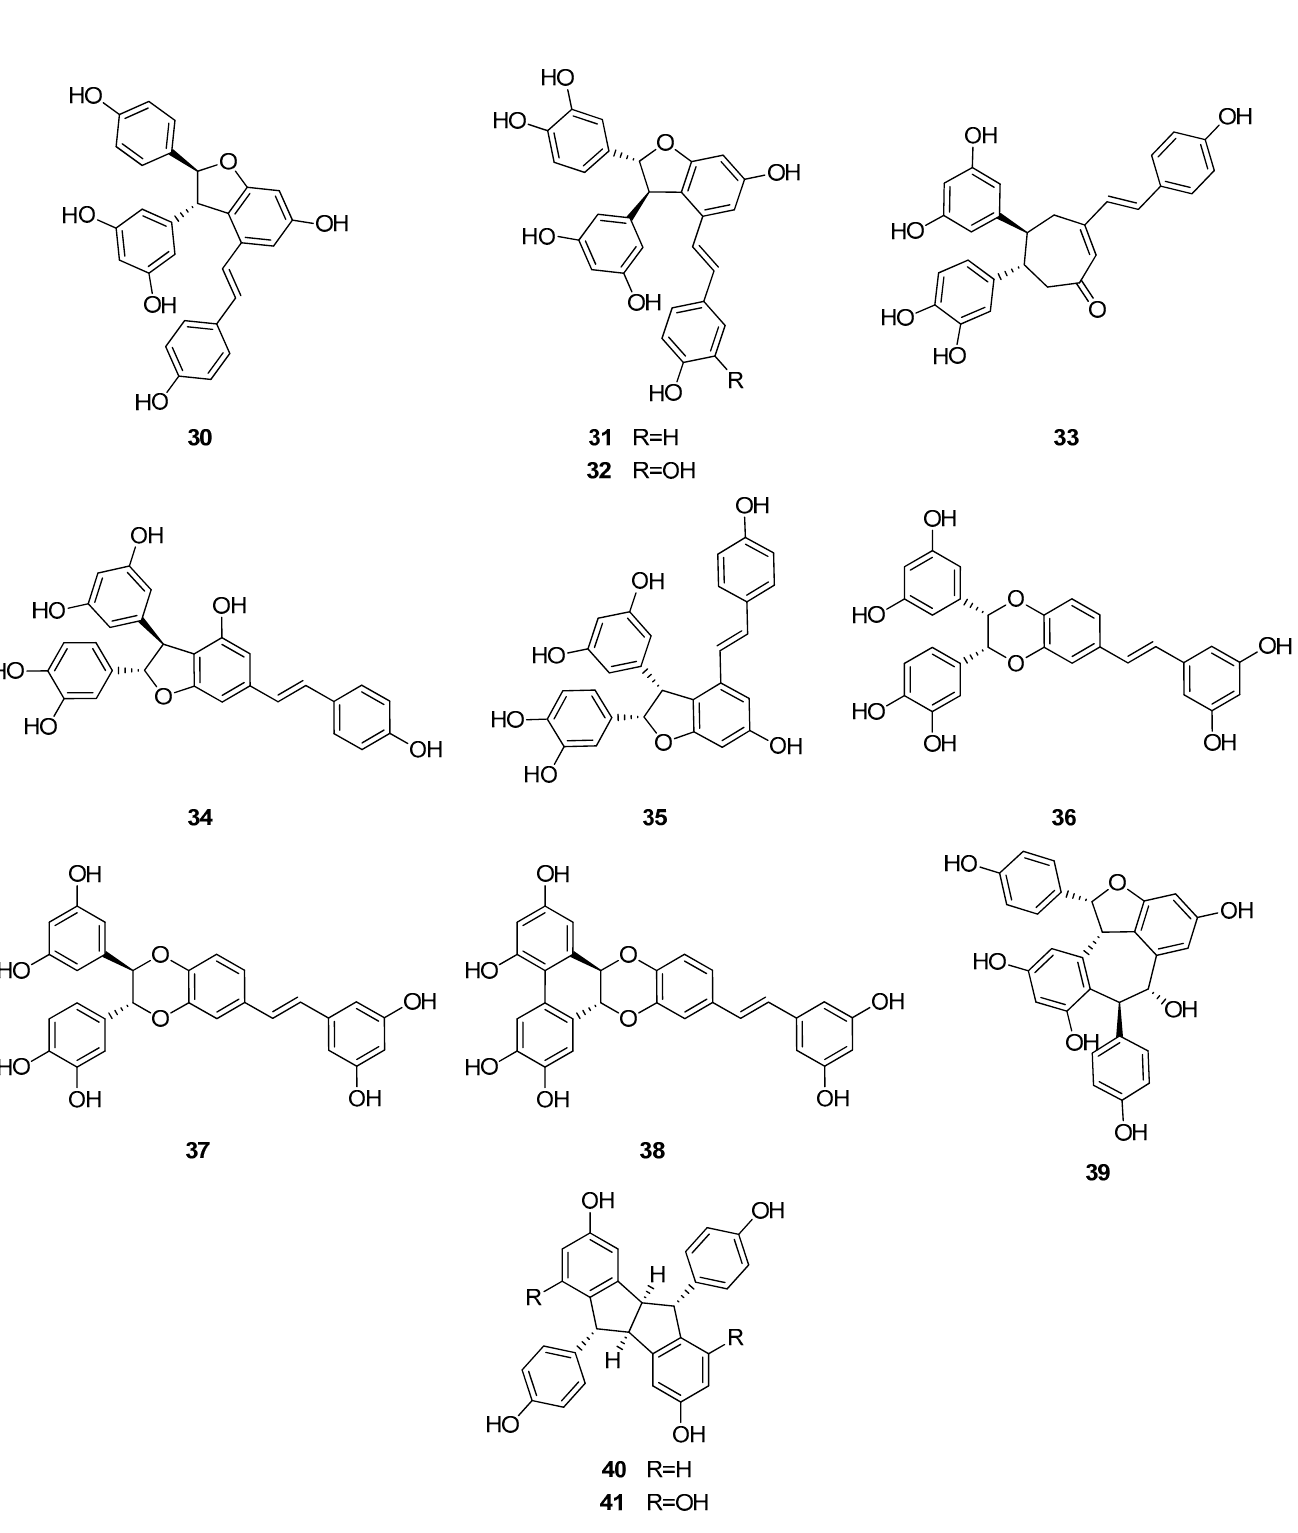
Figure 4. Dimeric stilbenes isolated from Cyperaceae species . (+)- α -Viniferin ( 42 ) is a common stilbene trimer in Cyperaceae species ( Carex glauca , C. gynandra [31], C. humilis [46], and C. baccans [47]), originating from the condensation of 3 resveratrol monomers (Figure 5).